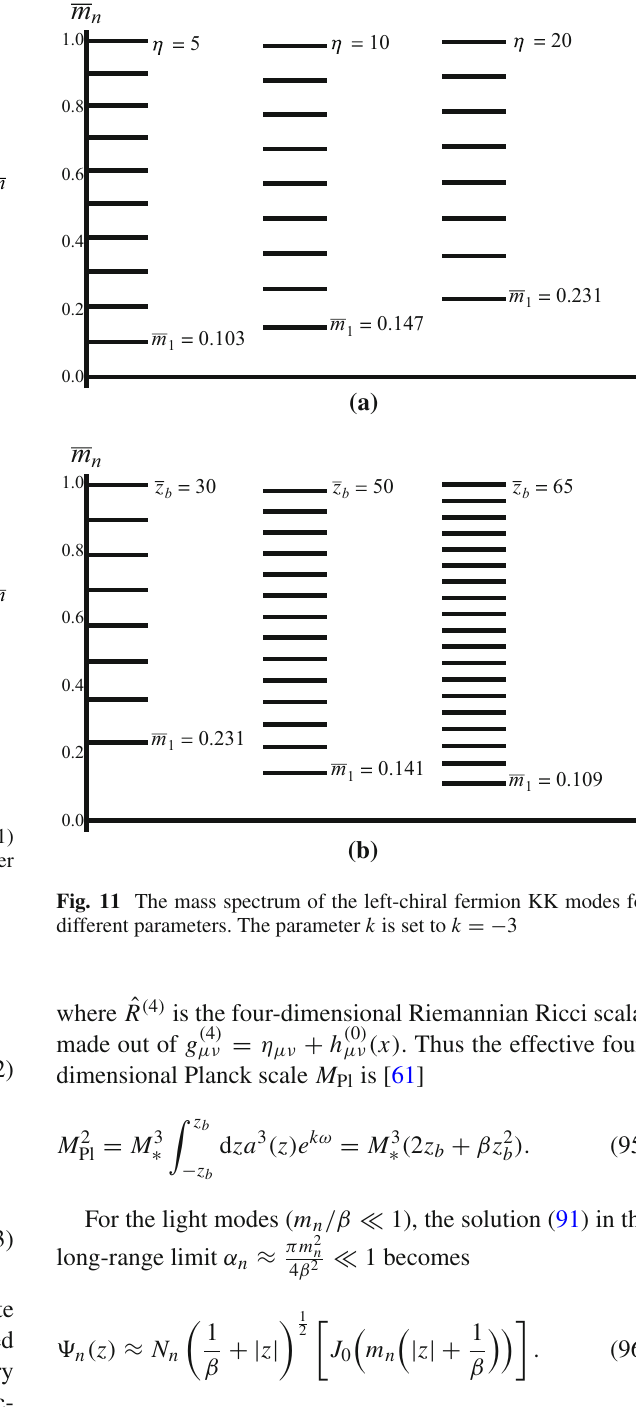
Correspondingly, the spectrum of KK gravitons is [61]